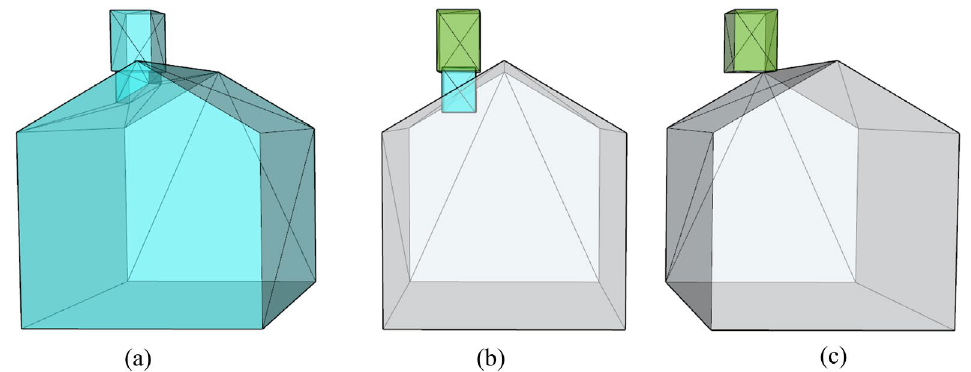
Figure 1. Component separation occurs when existing algorithms simplify multi-component building models: ( a ) the model with continuous mesh; ( b ) the multi-component model (different colors represent different components); ( c ) the simplified multi-component model.